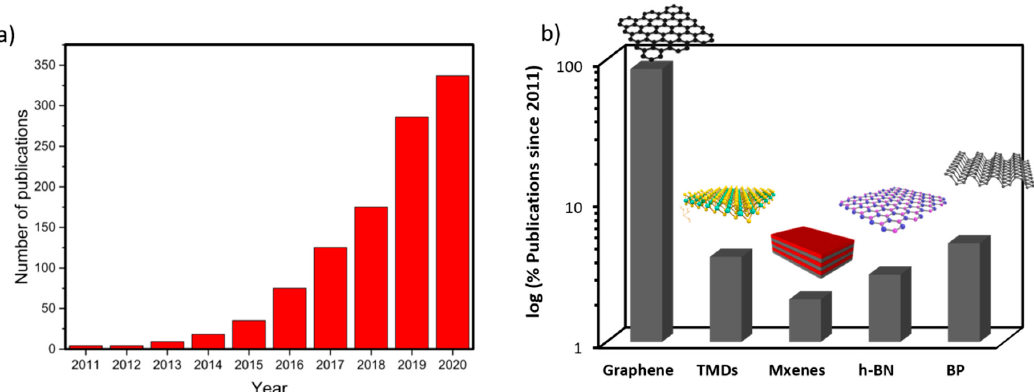
Figure 1. Statistics bibliography research by Web of Science: ( a ) Number of publications per year under the topics: 3D printing combined with 2D materials, Graphene, Mxenes, TMDCs, MoS 2 , Black phosphorous, Boron nitride and ( b ) Relative percentage of publications since 2010 per 2D material in the 3D printing field.